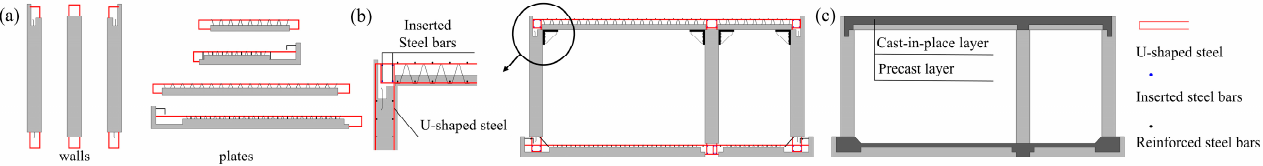
Figure 2. Construction of the new type of prefabricated underground utility tunnel: ( a ) step 1: prefabrication of specimen; ( b ) step 2: assembly of precast components; and ( c ) step 3: concrete pouring of the laminated layer and joints.